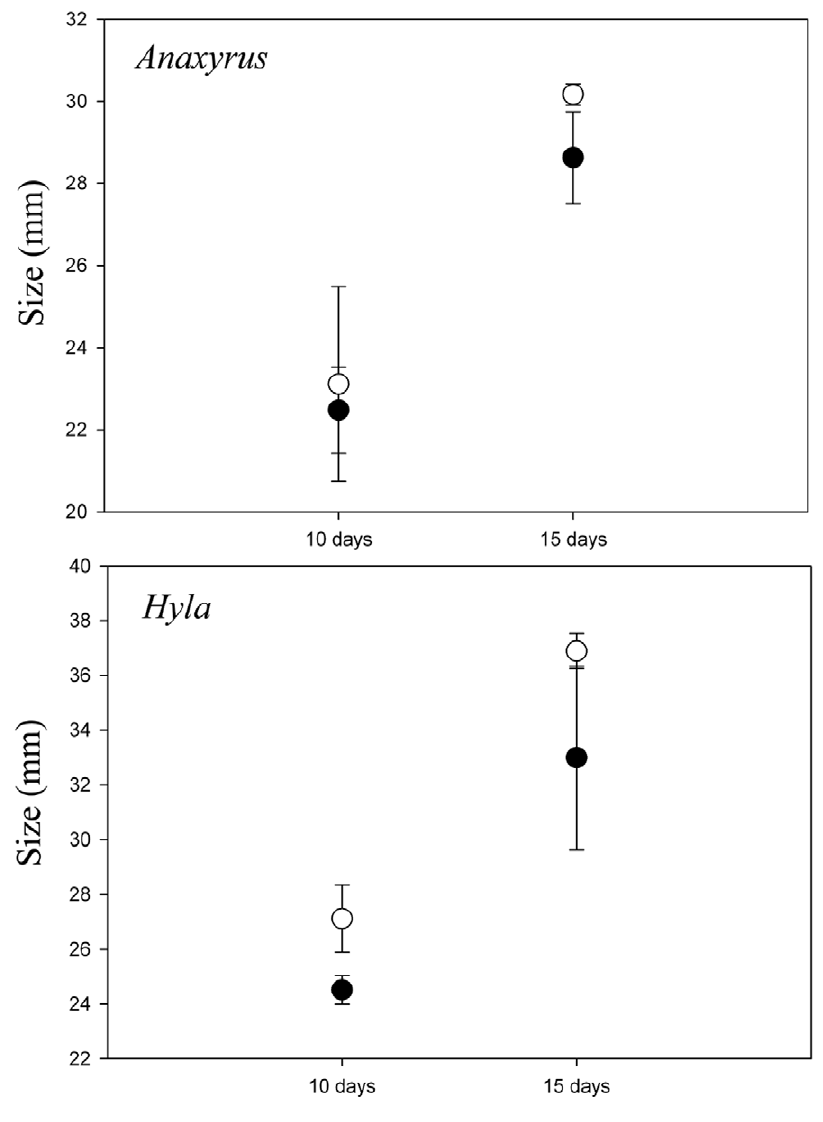
Figure 4. Size (mm) of Anaxyrusfowleri and Hylaversicolor tadpoles raised for 10 and 15 days. Data points represent tank means ( 6 1 SE). Open circles are tadpoles raised in the absence of disease; filled circles are tadpoles raised in the presence of Batrachochytrium dendrobatidis ( Bd ). Overall, tadpoles raised in the presence of Bd were smaller compared to tadpoles raised without Bd (F 1,22 =8.65, p=0.008).